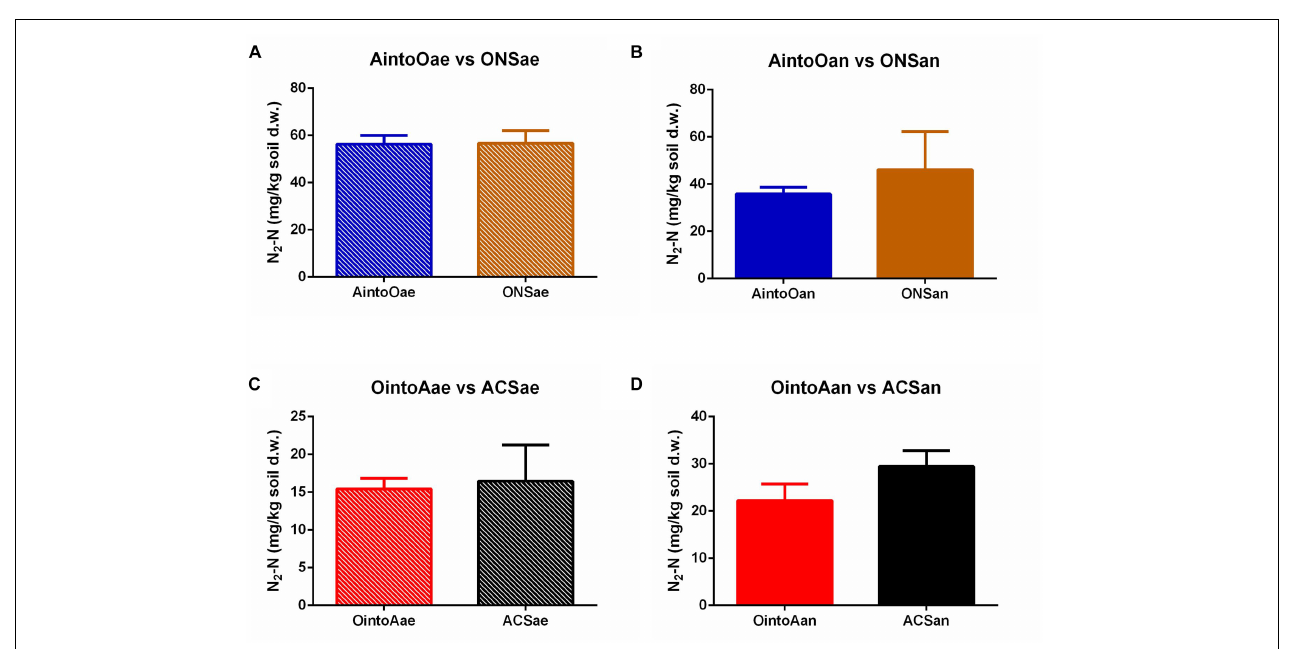
FIGURE 4 | Dinitrogen content in different treatments after 100 h of kinetics monitoring. (A) AintoOae and ONSae. (B) AintoOan and ONSan. (C) OintoAae and ACSae. (D) OintoAan and ACSan. The bars indicate the means, and the error bars indicate the SD. No significant differences in the N 2 -N levels were observed between the inoculated and uninoculated